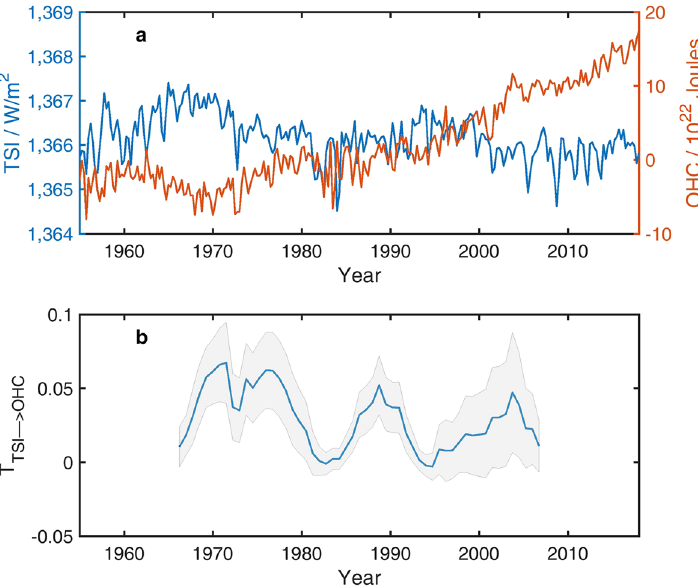
Figure 1. The original incorrect version of Figure 1.